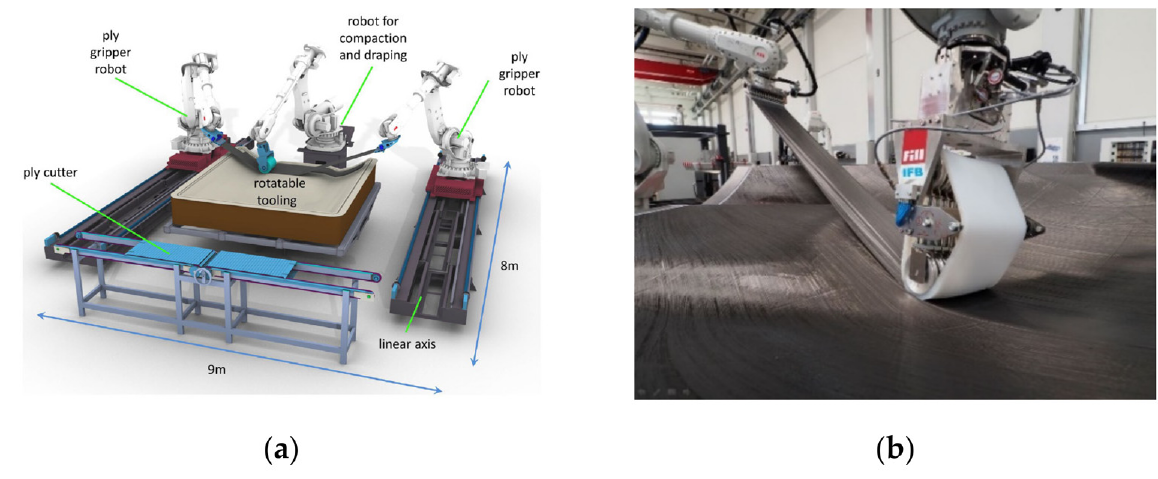
Figure 1. ( a ) APP principle [7]; and ( b ) APP end effector